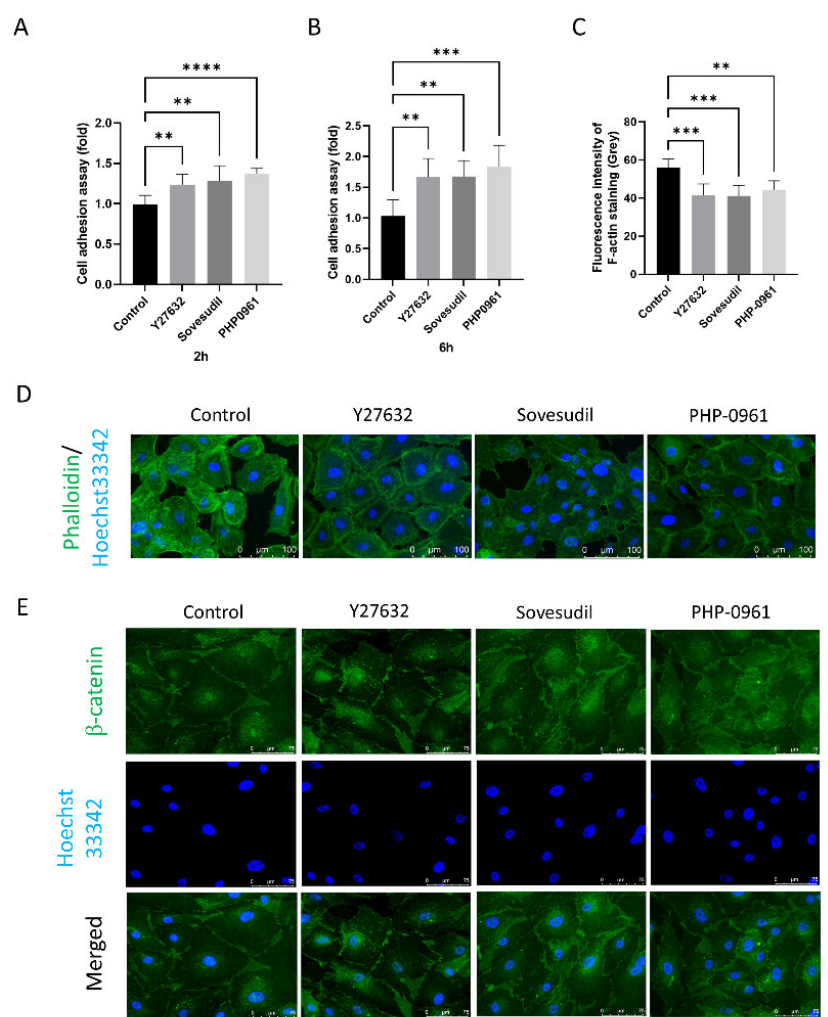
Figure 3. Cell adhesion assay. ( A , B ) Cell adhesion was evaluated by crystal violet assay at 2 h and 6 h. ( C , D ) Phalloidin staining was performed to evaluated F-actin pattern and fluorescence intensity of F-actin. ( E ) β -catenin was evaluated by immunofluorescence staining. ** p < 0.01, *** p < 0.001 and **** p <